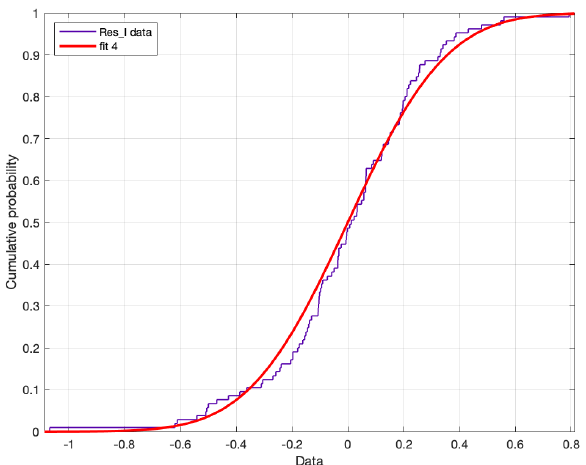
Figure 8. The standard normal distribution (red line) and the empirical distribution (blue line) of the standardized residuals for